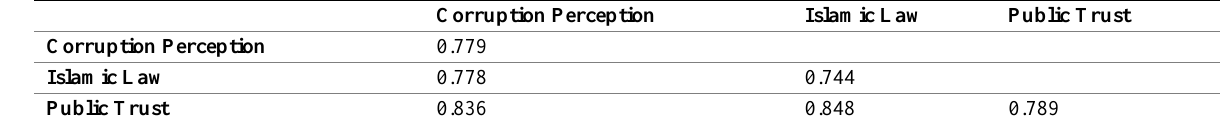
Table 3: Discriminant Validity